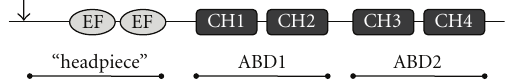
Figure 1: Schematic of the structure of LPL. The N-terminal “head- piece” contains at least one serine phosphorylation site (arrow; ser- ine residue 5) and EF hand loops (labeled “EF”) that are thought to participate in the calcium regulation of LPL. The C-terminal portion contains two tandem ABDs, each of which consists of two calponin-homology (CH) domains, which are numbered.